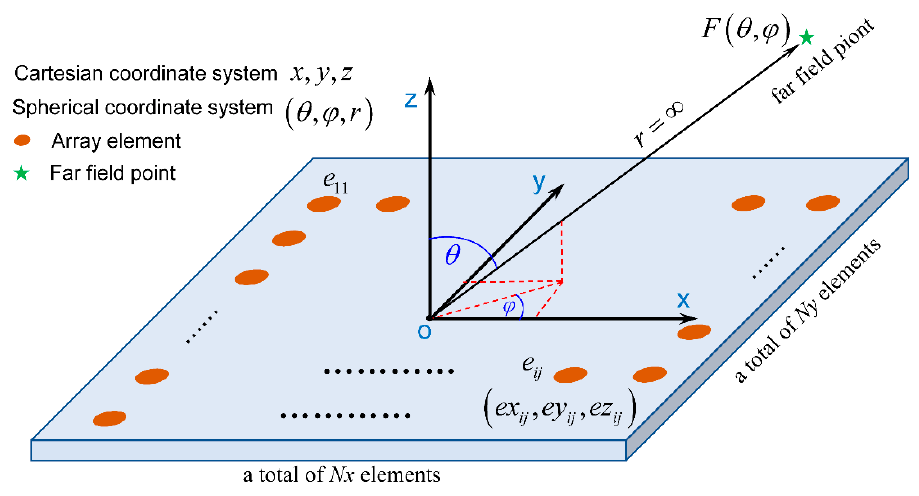
Figure A1. The pattern of the array antenna.